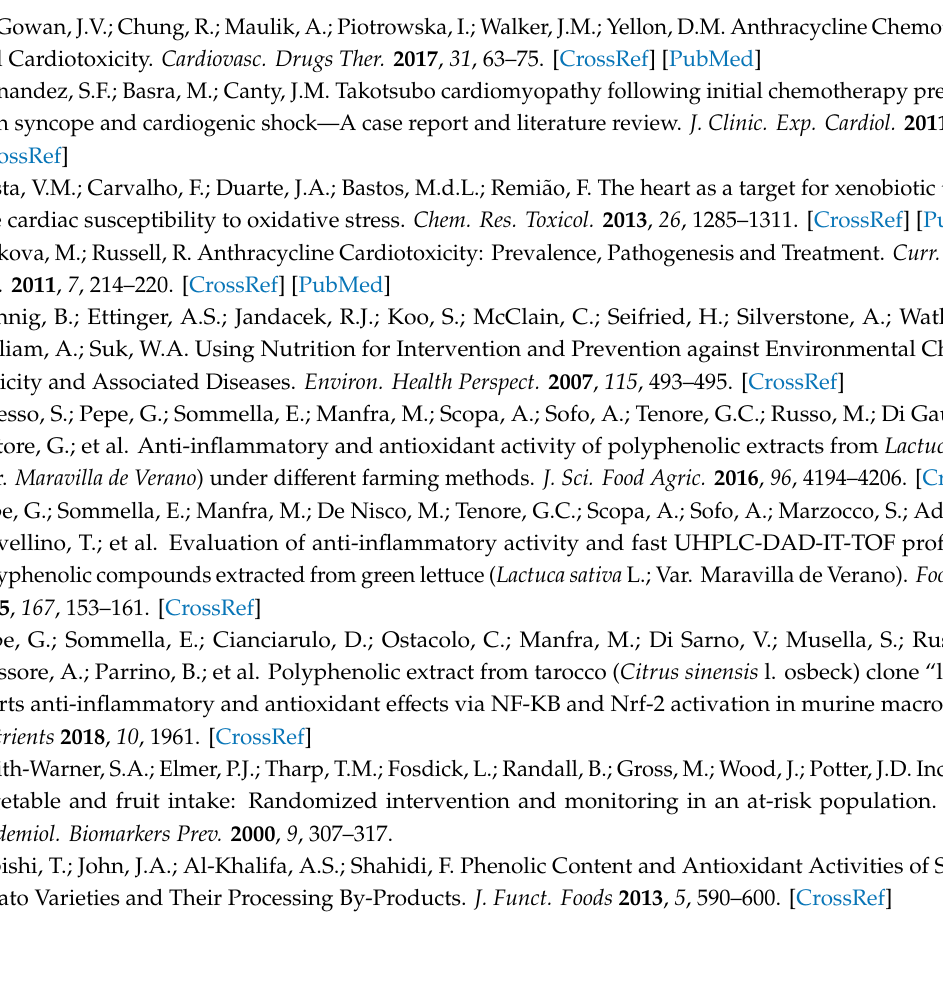
Figure S1: MS (top) and MS / MS (bottom) spectra of ( a ) apigenin 6,8-C- β -d-glucopyranoside, ( b ) narirutin, ( c ) hesperidin, ( d ) nomilinic acid glycoside and ( e ) deacetyl-nomilinic acid glycoside; Figure S2: E ff ect of orange and red grapes extracts, and the 3 relative mixtures (25–1 µ g / mL) alone on viability of H9c2 ( a , b ) and MCF-7 ( c , d ) cells. Data are expressed as mean ± S.E.M. of % of cell viability; Table S1: Qualitative profile of polyphenols isolated in Citrus sinensis smoothie; Table S2: RP-UHPLC-UV / Vis-ESI-IT-TOF identification of anthocyanins isolated from Vitis vinifera L. cv. (Aglianico N.)